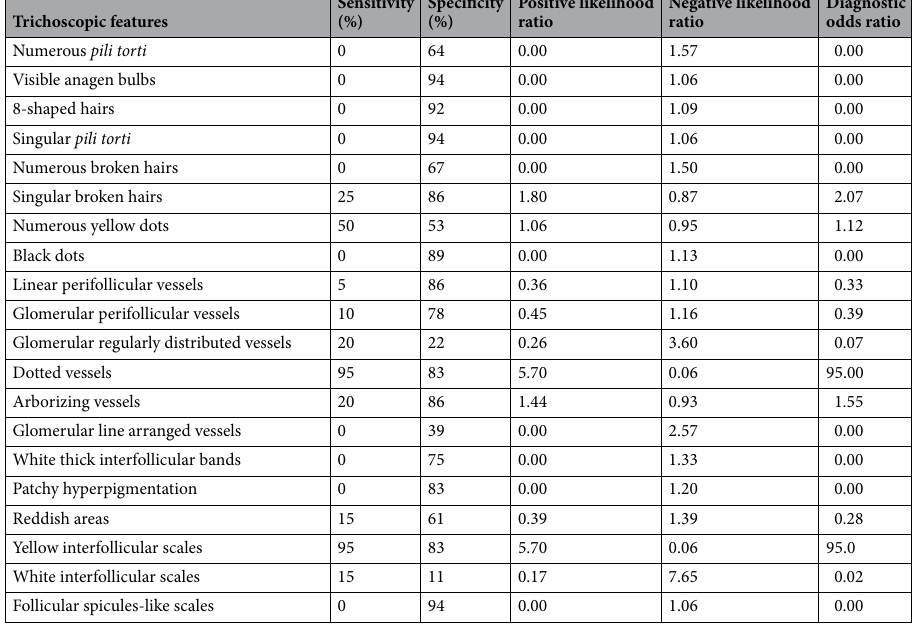
Table 3. Sensitivity, specificity, positive and negative likelihood ratio and diagnostic odd ratio of trichoscopic criteria for erythrodermic atopic dermatitis vs erythrodermic psoriasis and erythrodermic cutaneous T-cell lymphoma.